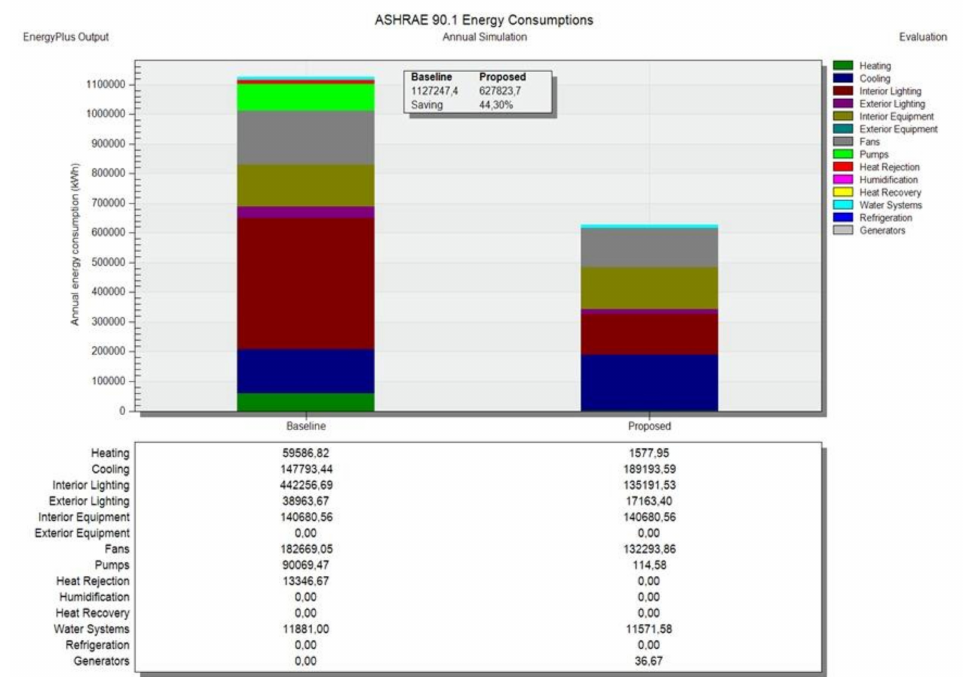
Figure 11. Annual simulation of energy consumption. Comparison chart according to ASHRAE standard 90.1. Program Version: EnergyPlus, Version 9.4.0. Report: Annual Building Utility